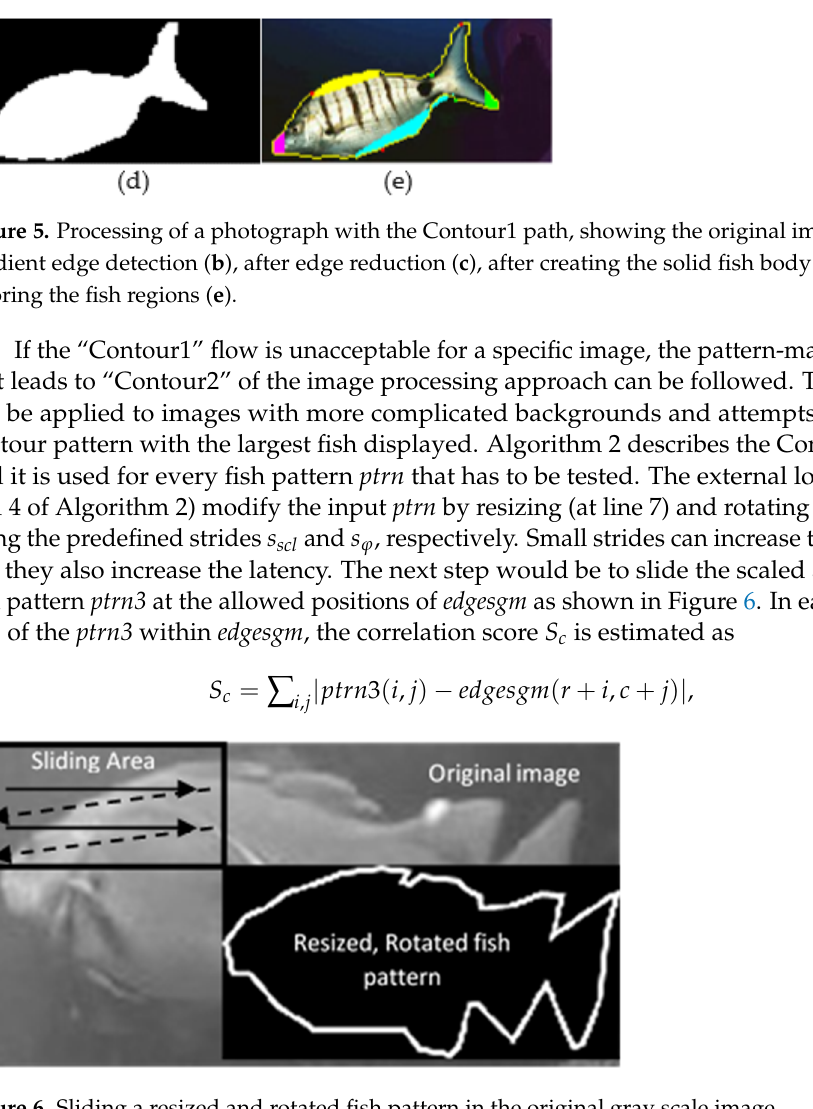
Figure 6. Sliding a resized and rotated fish pattern in the original gray scale image.